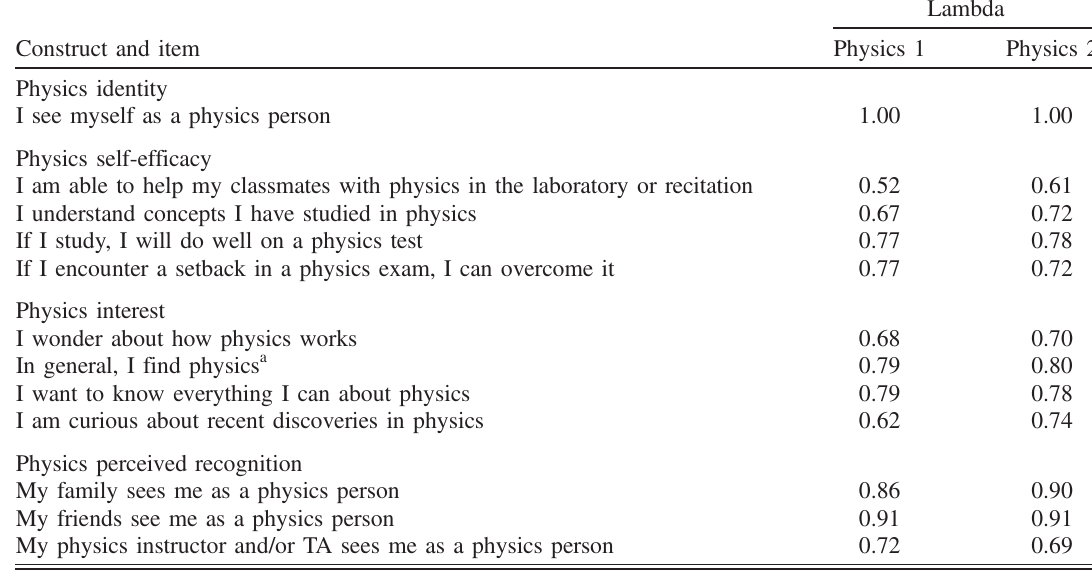
TABLE I. Survey questions corresponding to each of the constructs, along with factor loadings from the confirmatory factor analysis for all matched students ( N ¼ 563 ) in physics 1 and physics 2. The questions in the study were designed on a Likert scale of 1 (low endorsement) to 4 (high endorsement) [92]. The rating scale for most of the self-efficacy and interest questions was: NO! no yes YES! while the rating scale for the physics identity and perceived recognition questions was strongly disagree, disagree, agree, strongly agree. All p values (for the significance test of each item loading) are p < 0 . 001